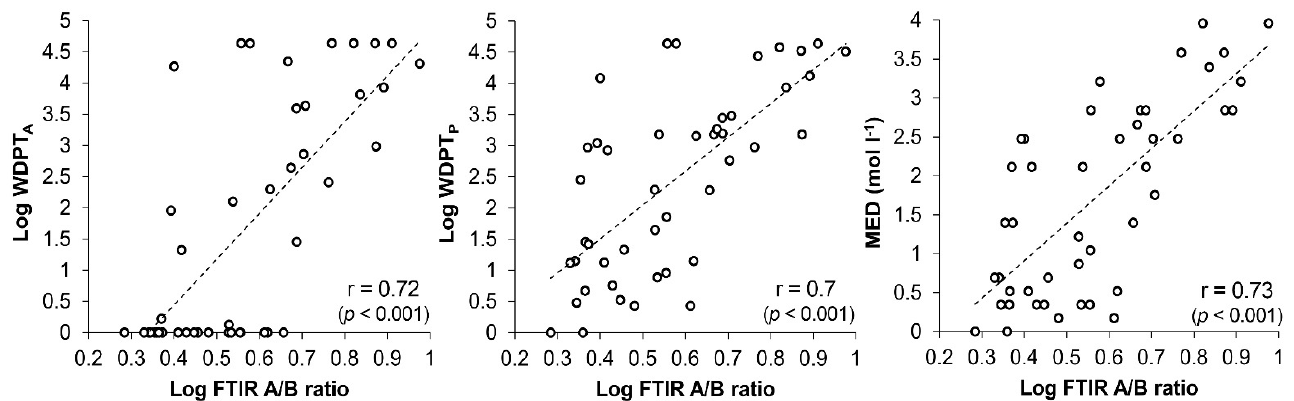
Figure 3. Scatter plots showing general collinearity between SWR data and FTIR A/B ratio. The term A represents the sum of the peak areas integrated within the band Nos. 1, 5, and 7 (Table 1) and sum of the peak areas associated with 5 remaining bands (Nos. 2–4 and 6–8 in Table 1) are represented by B.